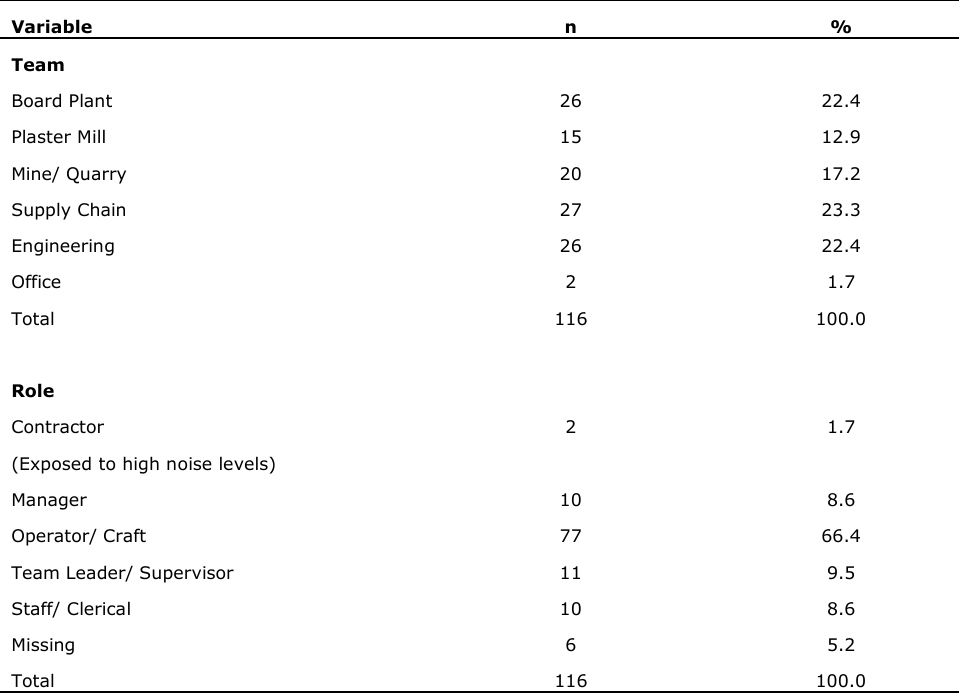
Table 1. Population